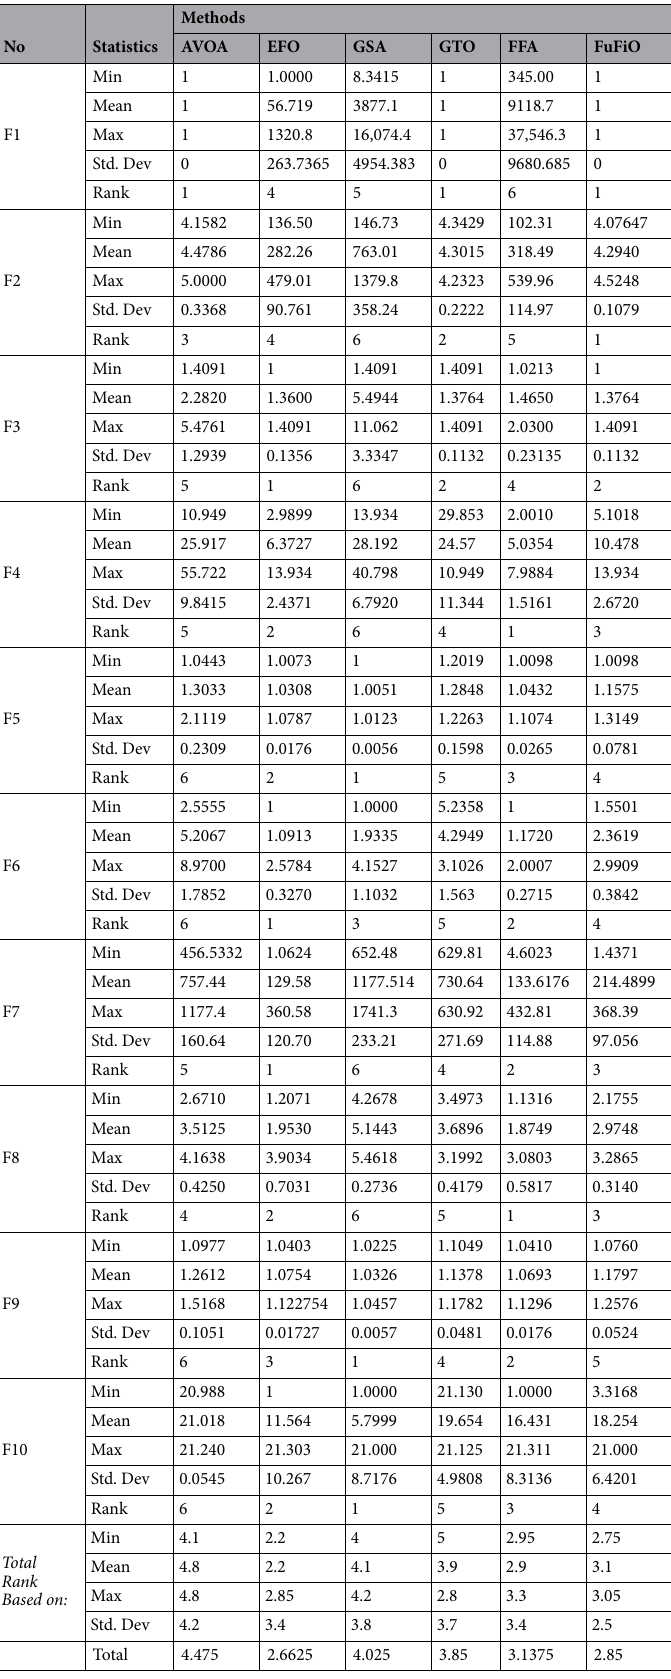
Table 19. Statistical results of different algorithms for the CEC-2019